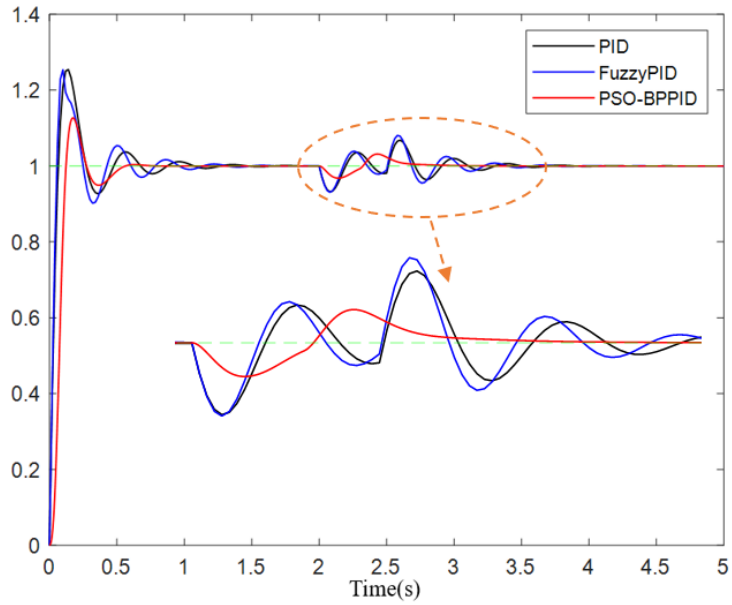
Figure 14. Anti-disturbance simulation curves.